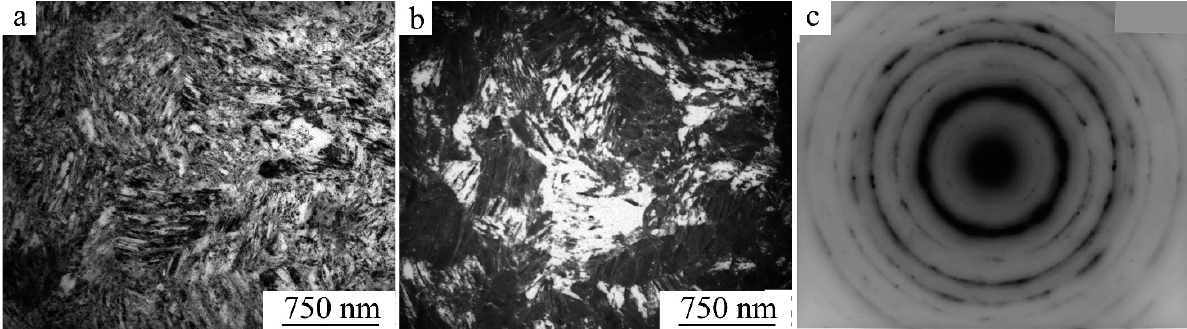
Figure 12. ( a ) The bright- and ( b ) dark-field TEM images of the microstructure (in transverse cross section), and ( c ) the corresponding SAED pattern (SD 0.3 µm), taken from the ECAP-treated UFG Ti 49.4 Ni 50.6 alloy in the neck region [73].